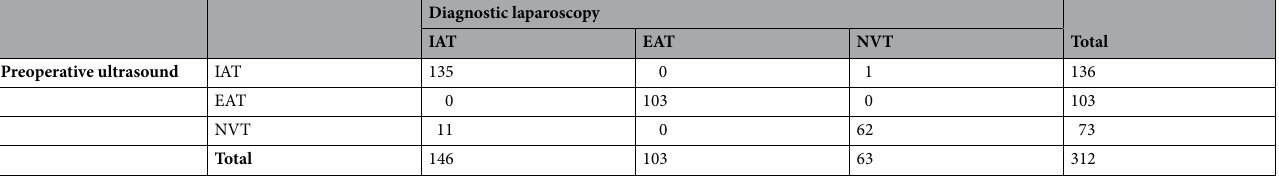
Table 3. The Crosstabulation of preoperative ultrasound and diagnostic laparoscopy.